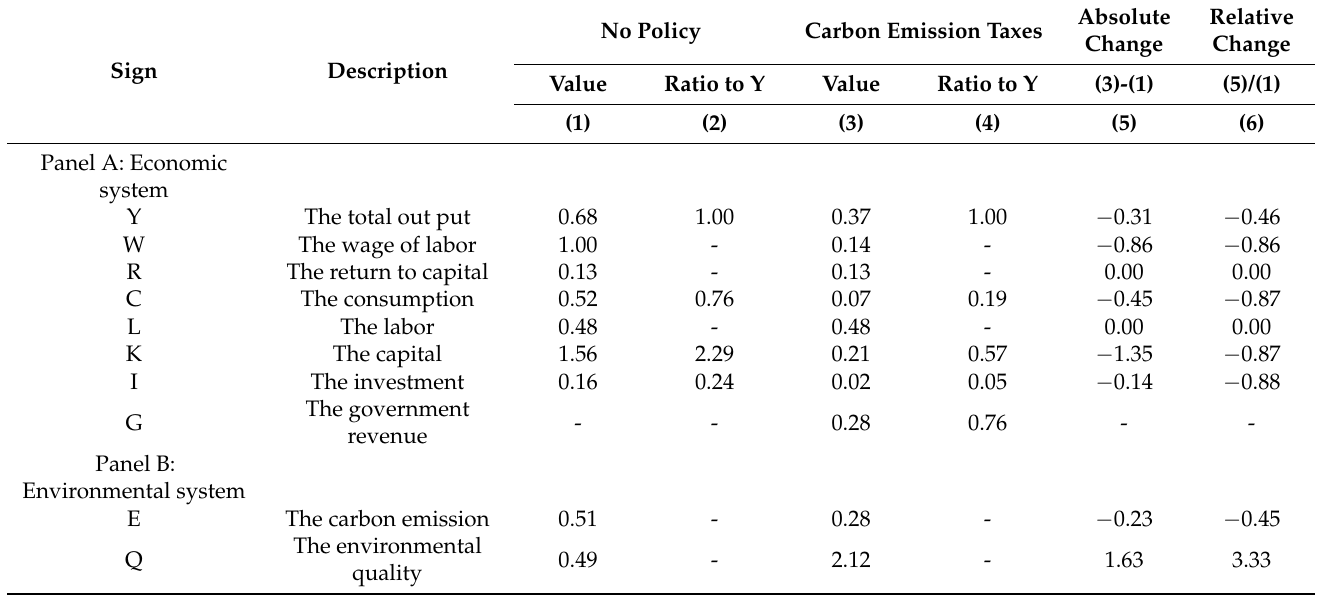
Table 3. Steady state values for the economic and environmental systems in different